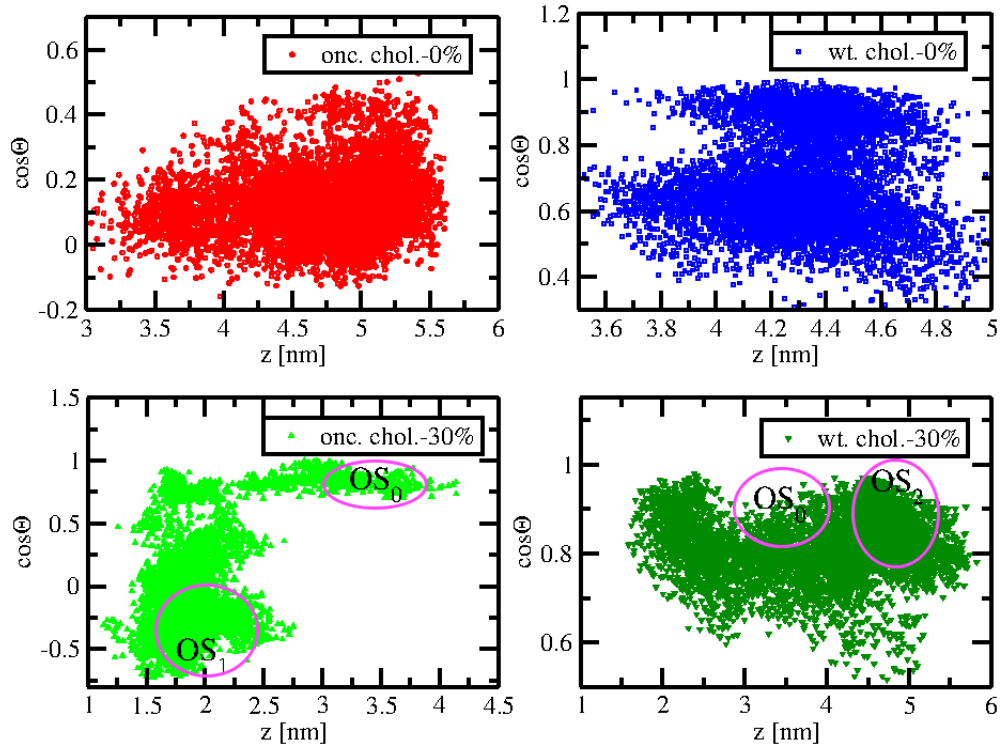
Figure 4. Density distributions of configurations of the oncogenic KRas-4B-Far and wild-type KRas-4B-Far systems with given values of coordinates z and cos Θ for 0 and 30% cholesterol. Observed OS 1 , OS 2 , and OS 0 have been encircled in their corresponding